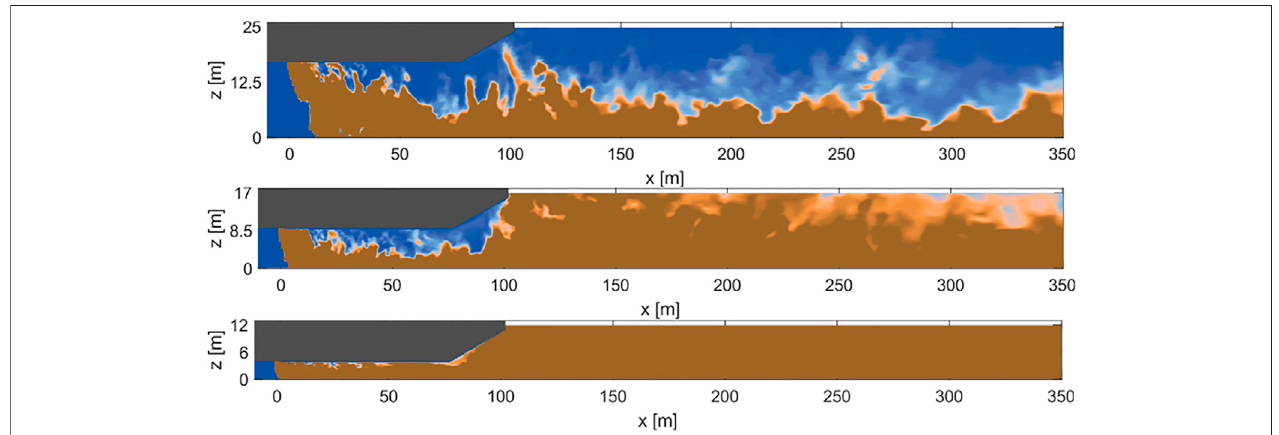
FIGURE 5| Illustration ofthe in fl uence ofthe depth/under keel clearance on TSHD over fl ow dredge plume mixing (de Wit et al., 2014a, b) for three differentdepths with all else similar (Ri = 1.2 and γ = 1.3). The propellers of the TSHD are included in the simulation and by entrainment pull some of the plume upward.